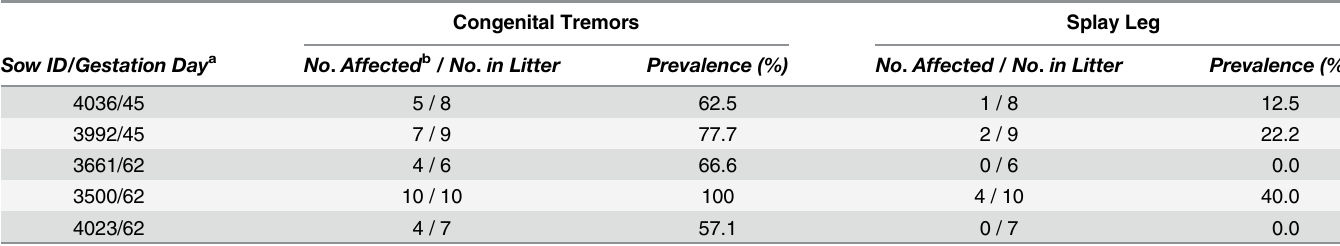
Table 3. Prevalence of Congenital Tremors and Splay Leg in Pestivirus-Inoculated Litters on Day 2 Post-farrowing. Congenital Tremors Splay